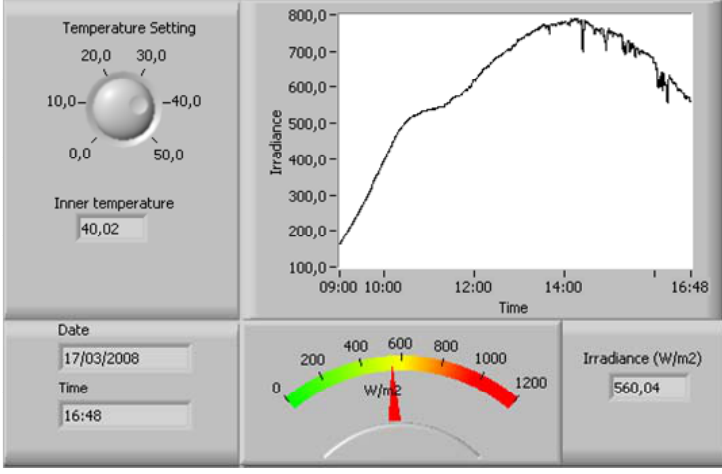
Figure 7. Virtual Instrument (VI) produced to control the